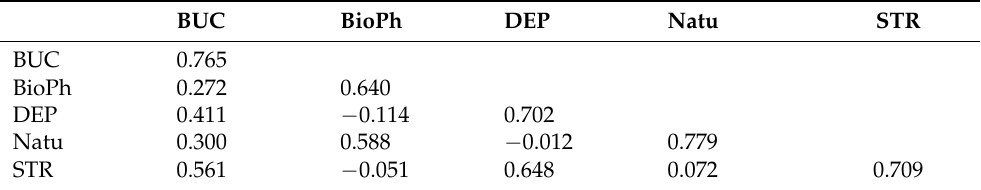
Table 3. Discriminant validity of modeling based on the Fornell–Larcker criterion.